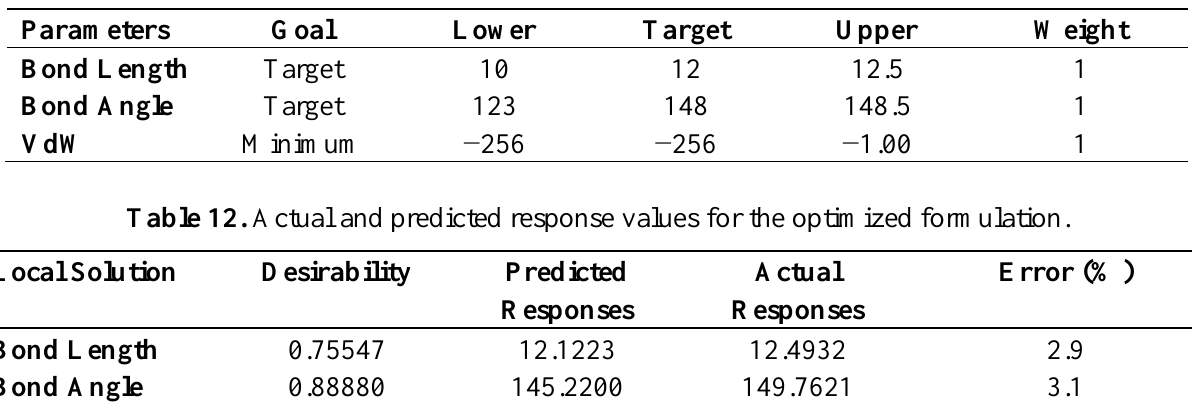
Table 11. Variable constraints employed for response optimization.